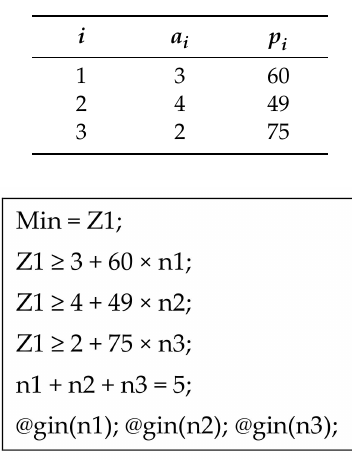
Table 3. Illustrative